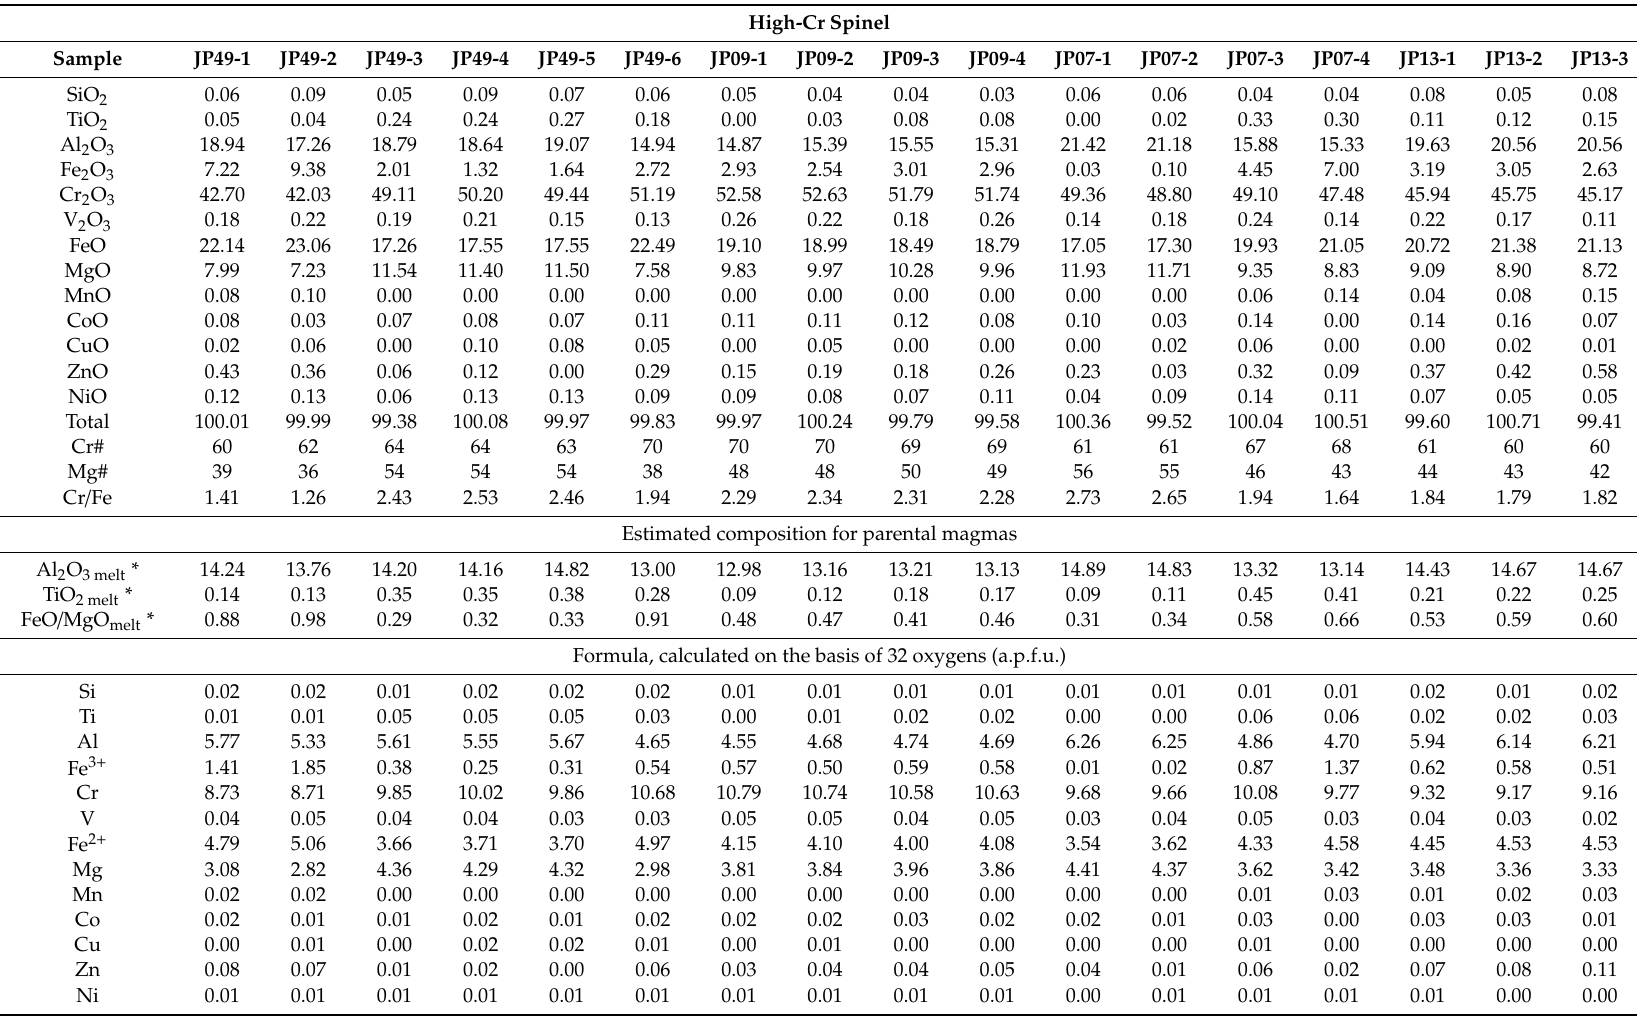
Table 3. The chemical composition of high-Cr and high-Al spinels (in wt%) with